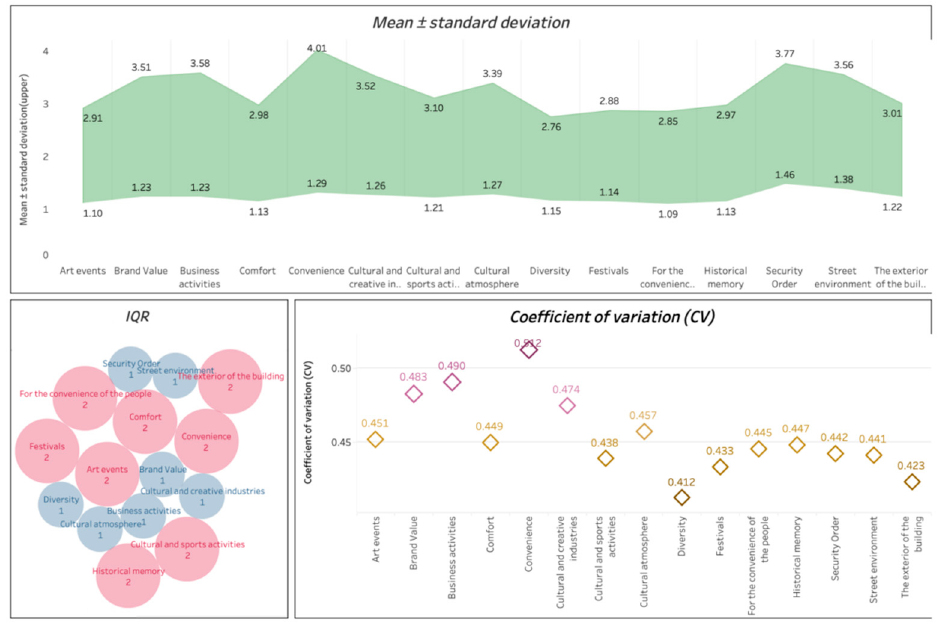
Figure 6. Analysis of average satisfaction degree for commercial space in Nonglin Street .